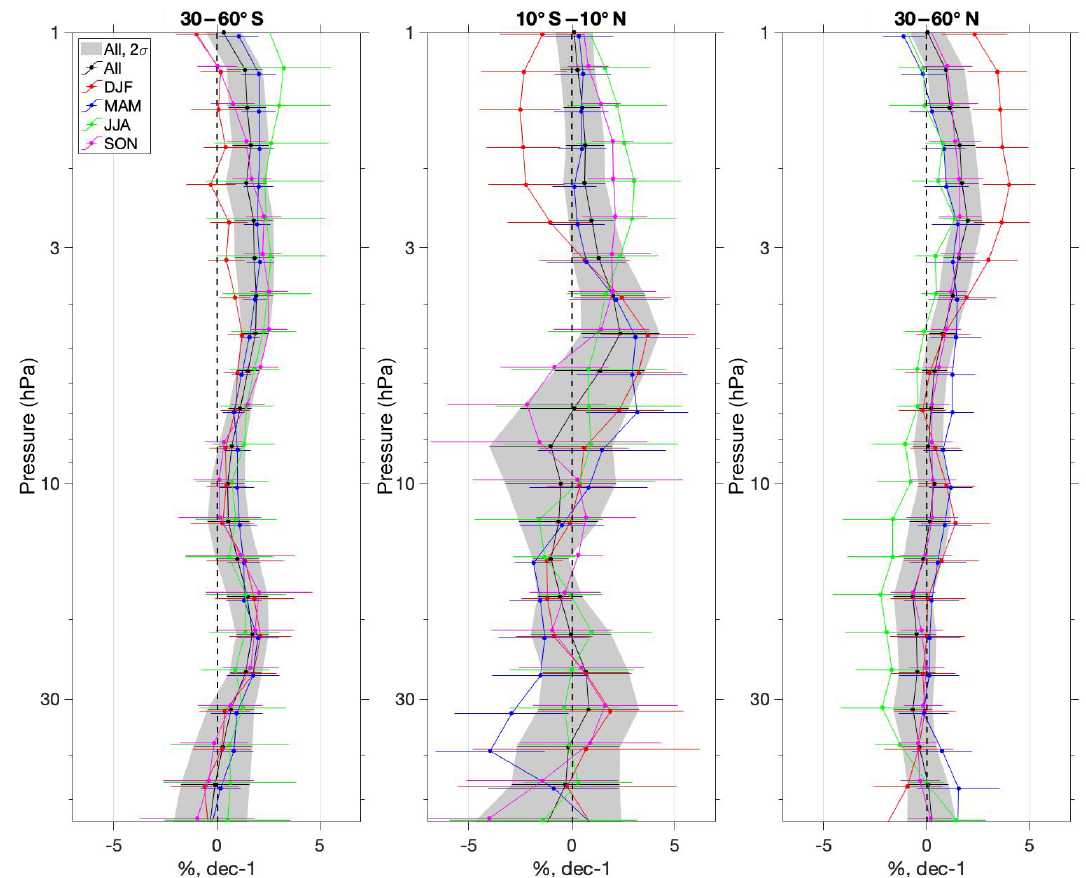
Figure 5. Vertical profiles of seasonal (red, blue, green, magenta) and yearly (black) ozone trends in 2000–2018 from SWOOSH. The results are shown for three selected latitude bands. Error bars and shaded area (gray) are 2 σ